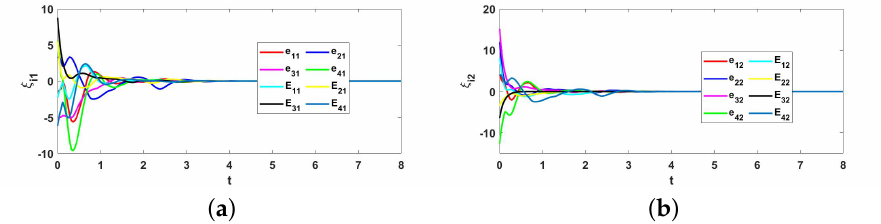
Figure 11. Formation tracking errors in Example 2. ( a ) formation tracking errors of ξ i 1 ; ( b ) formation tracking errors of ξ i